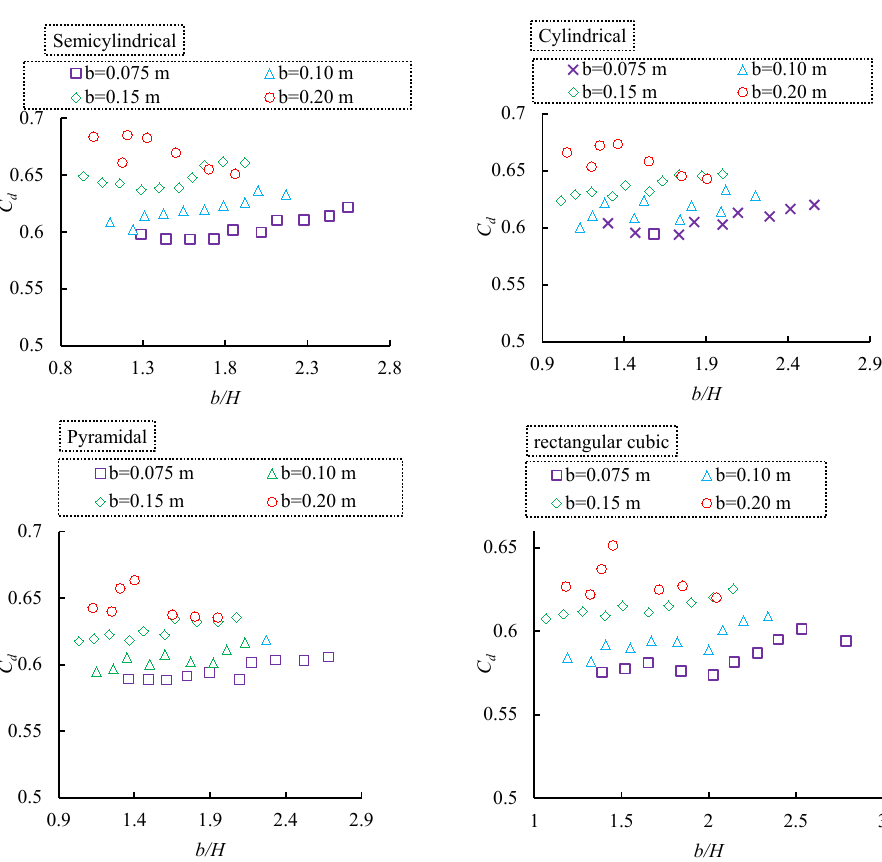
Figure 3. Discharge coefficients for different widths of sills. Table 2. Increase in sill gate discharge coefficients compared to non-sill gates (%).